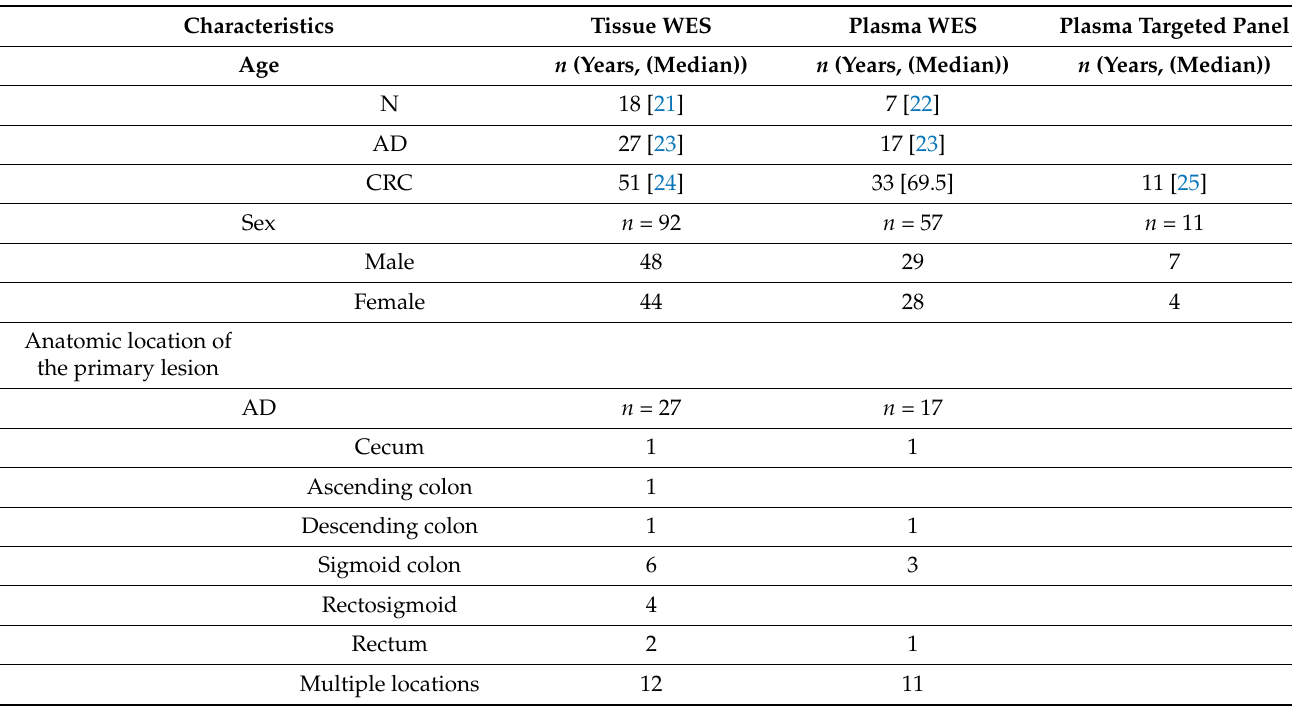
Table 1. Clinicopathological characteristics of patients analyzed in the current study (N—healthy, AD—adenoma, CRC—colorectal cancer